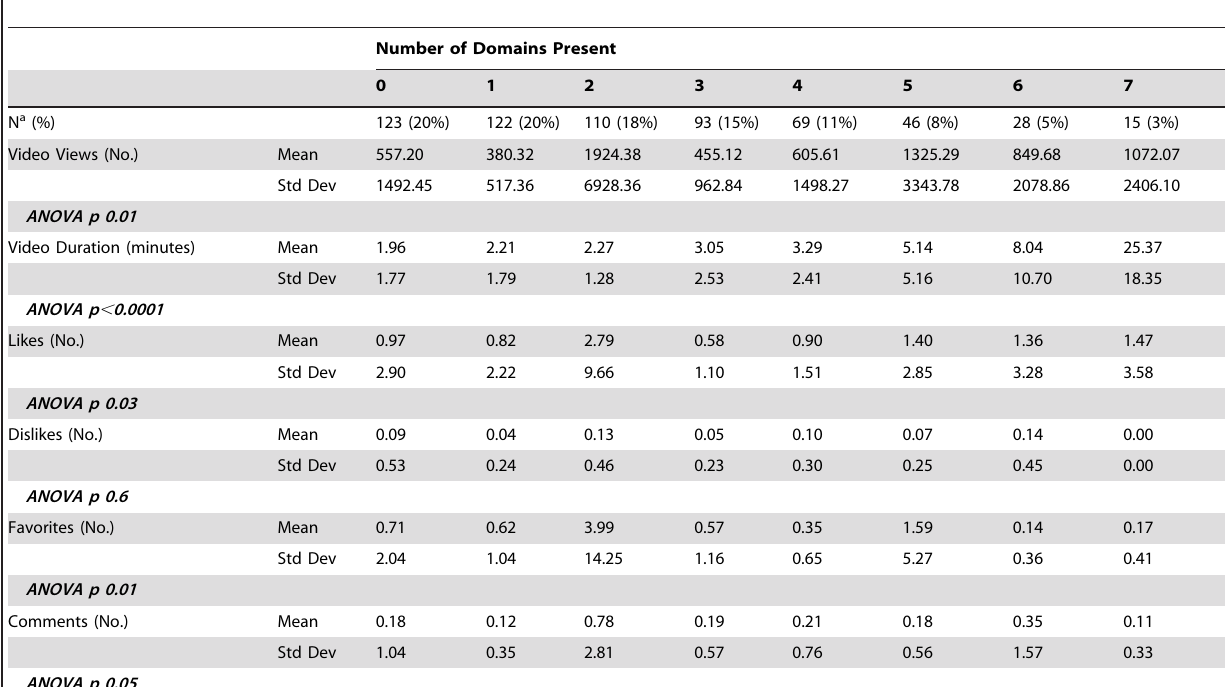
Table 2. Breadth of educational content based on user engagement metrics and video duration.